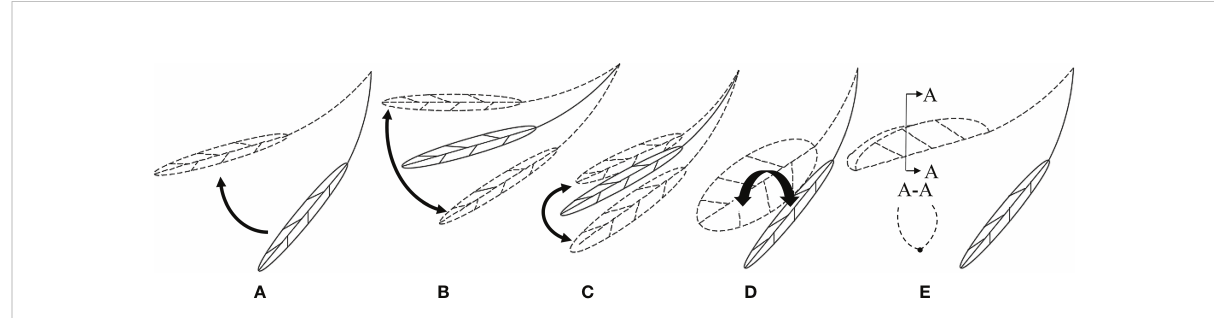
FIGURE 1 The morphological changes of the leaves in the air fl ow: (A) static lifting; (B) vertical swing; (C) horizontal swing; (D) torsional vibration; (E) wing